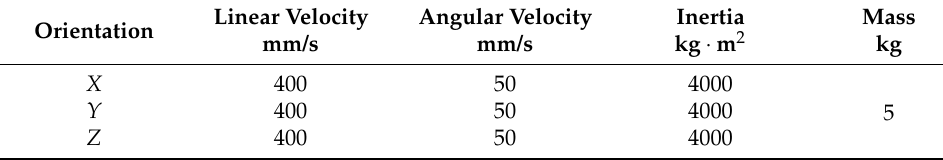
Table 2. The motion parameters of target.